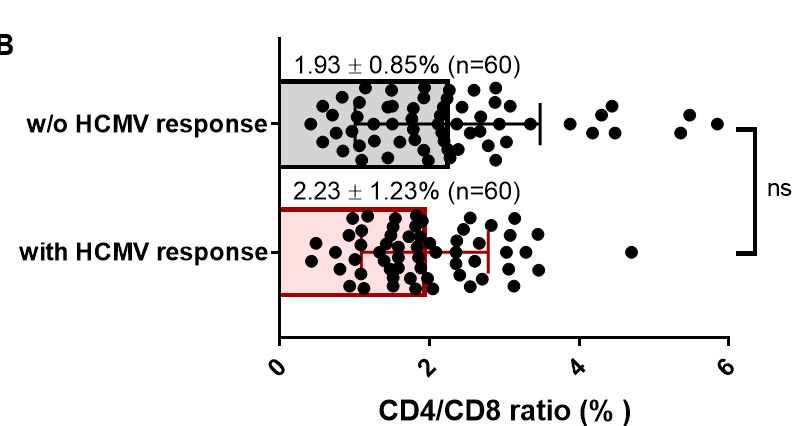
Figure 4. Frequency of blood CD8 and CD4/CD8 T cell ratio in HCMV+ healthy adults with or without detectable HCMV-specific CD8 T cells. ( A ) Scatter plots reporting the frequency of total CD8 T cells in blood samples from HCMV+ HD with at least one CD8 T response ( n = 60) or with no response detected under our conditions ( n = 60). Data are expressed as percent of total blood CD8 T cells for each HD. ( B ) Scatter plots reporting the CD4T/CD8 T cell ratio in blood samples from HCMV+ HD with at least one CD8 T response ( n = 60), or with no response detected under our conditions ( n = 60). Means and SD are shown. Each dot corresponds to a single PBMC sample from an individual HD. Statistical analysis was performed by Mann–Whitney U -test; p value is indicated.